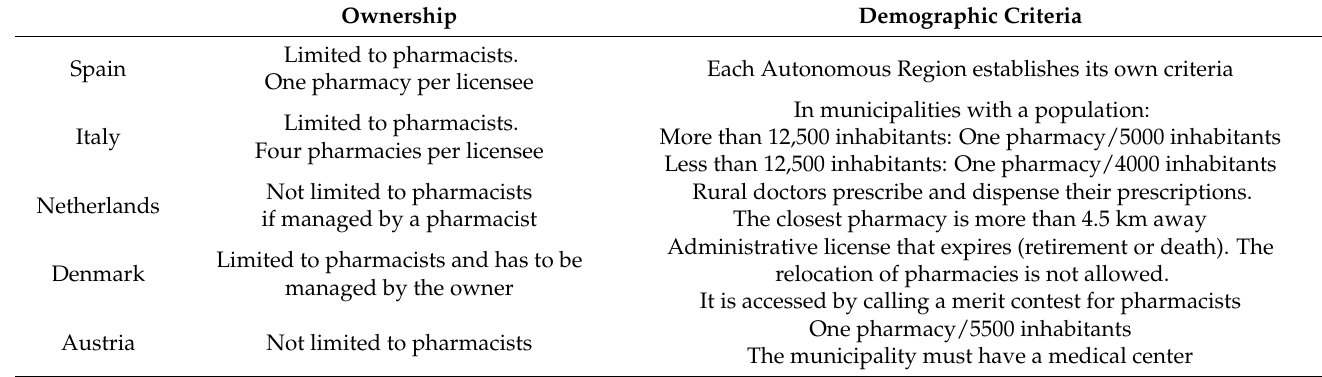
Table 1. Example of the main characteristics of the demographic and ownership criteria of pharmacies in EU countries. Ownership Demographic